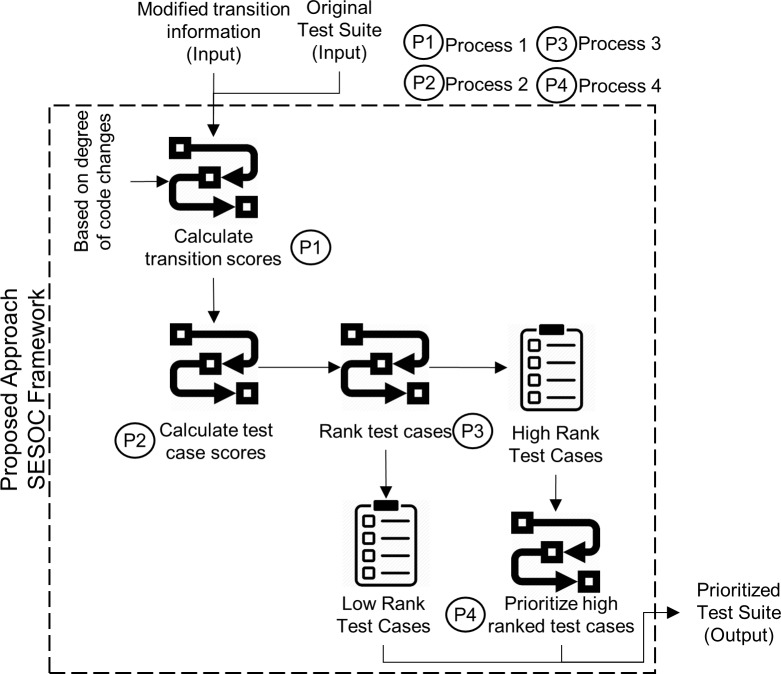
SESOC framework.